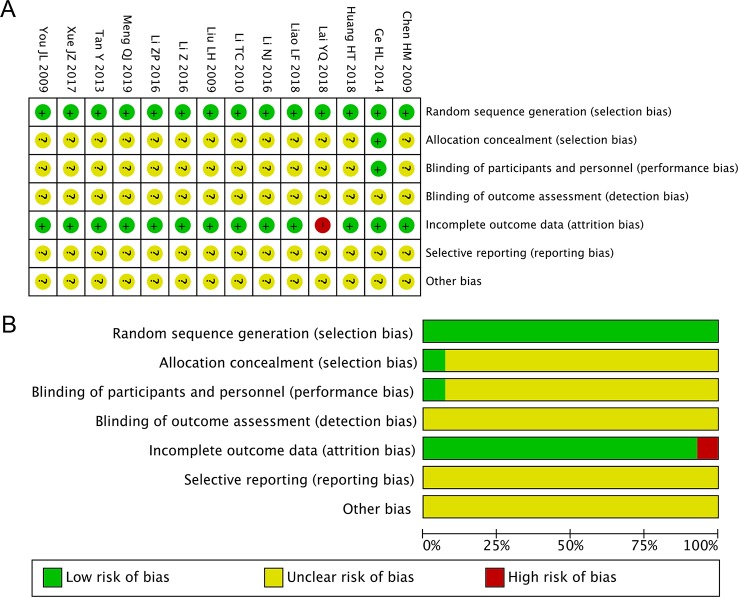
Risk of bias summary and diagram. (A) Risk of bias summary: review of authors' judgments about each risk of bias item for all included studies. (B) Risk of bias diagram: review of authors' judgments about each risk of bias item presented as percentages across all included studies. Red, green, and yellow indicate high, low, and unclear risk of bias, respectively.